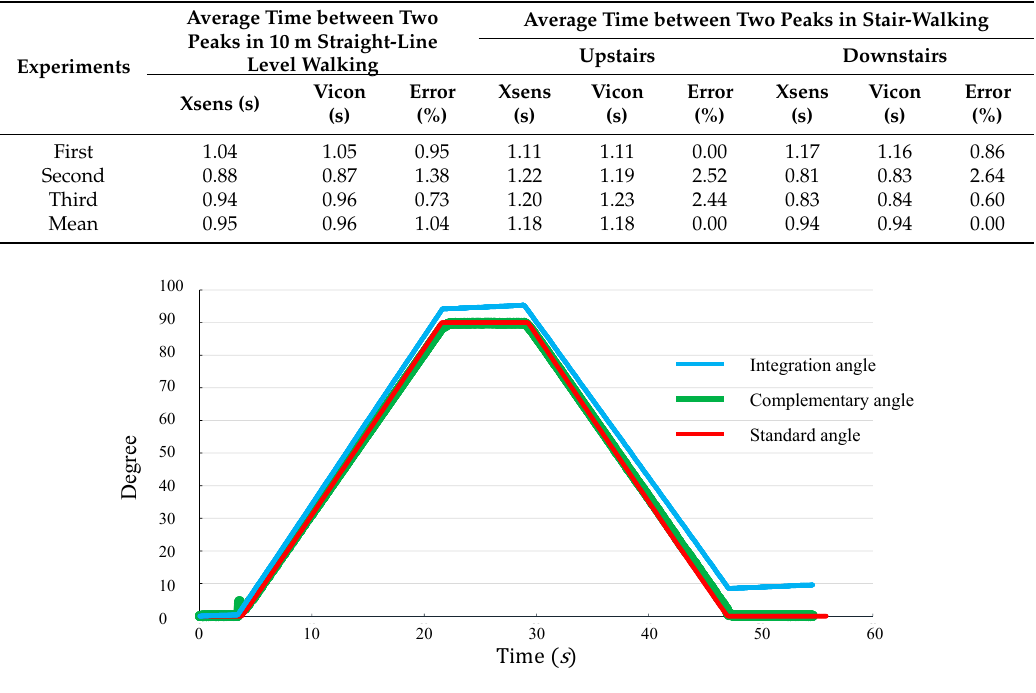
Figure 8. Results of 10-m straight-line walking: ( a ) average step time; and ( b ) total walking time.